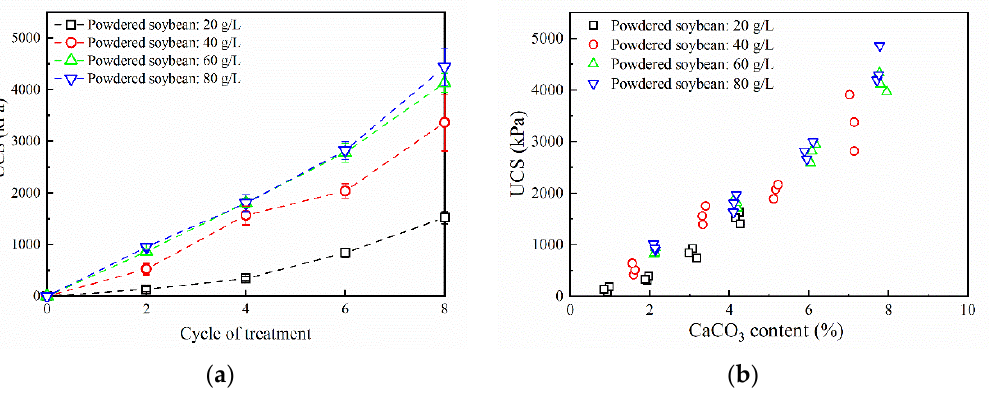
Figure 7. Effect of powdered soybean concentration on the unconfined compressive strength as a function of ( a ) cycle of treatment and ( b ) CaCO 3 content. function of ( a ) cycle of treatment and ( b ) CaCO 3